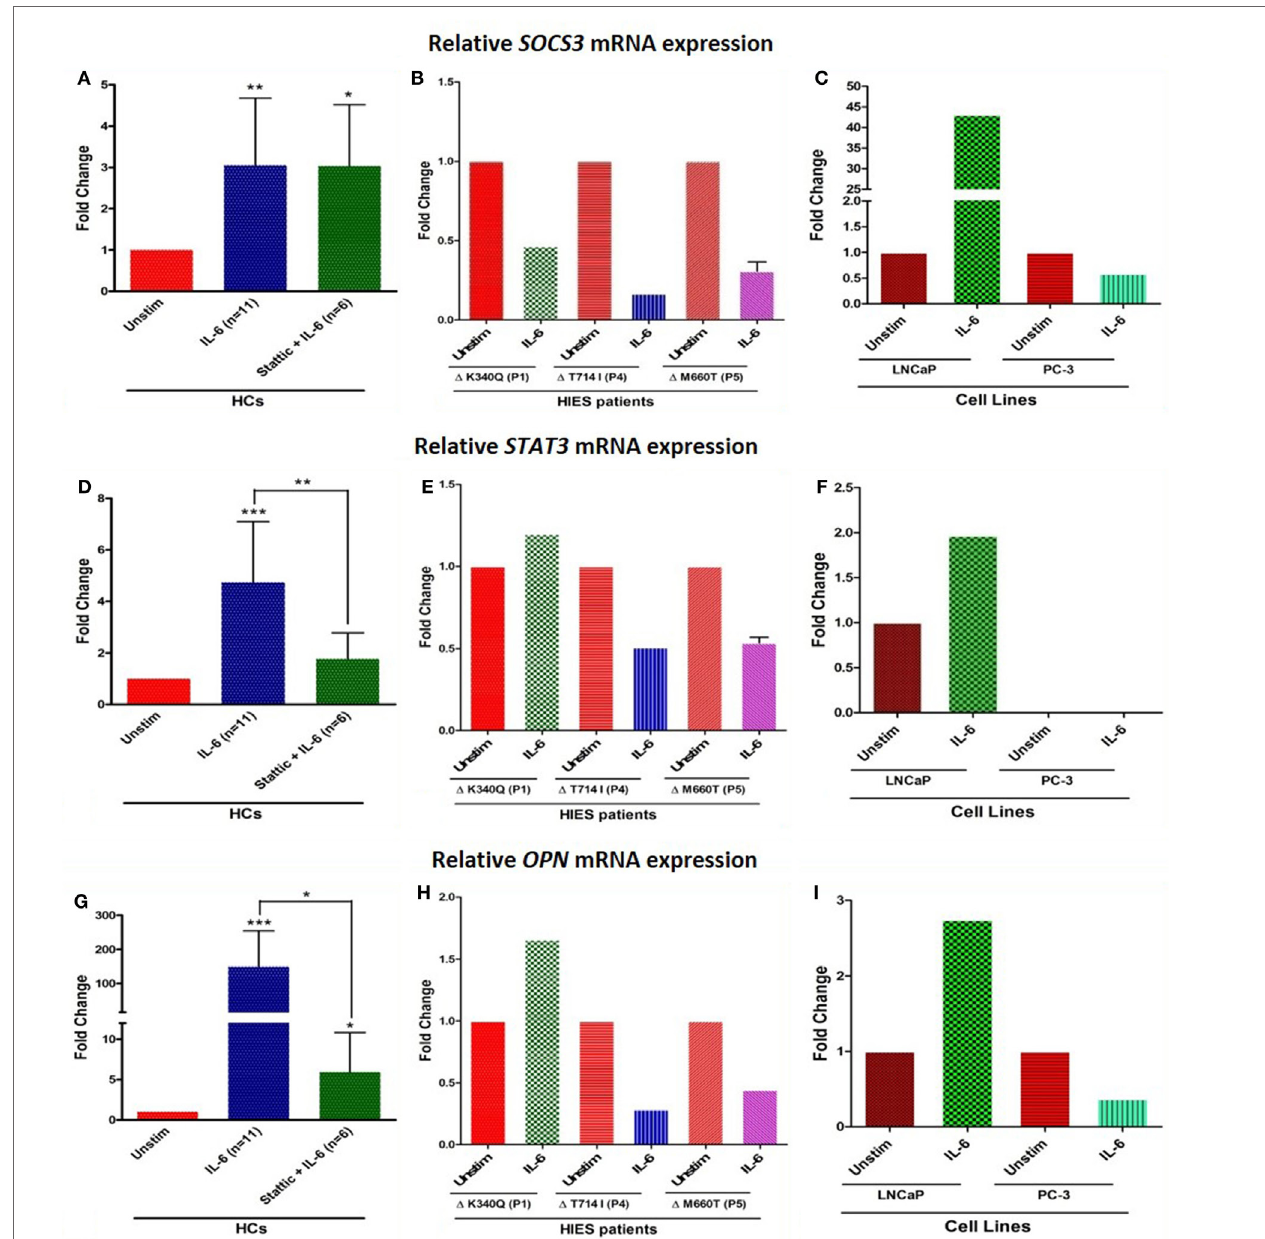
FigUre 4 | Bar graphs showing relative mRNA expression of SOCS3, STAT3 , and OPN in HC peripheral blood mononuclear cells (a,D,g) treated with either IL-6 alone or with stattic ; in hyper-IgE syndrome (HIES) subjects (B,e,h) treated with IL-6 alone and in LNCaP and PC-3 cells (c,F,i) treated with IL-6 alone. The primary transcript for each gene were assayed at least in duplicate and normalized to β -actin expression. Data represented as mean ± SD, * p < 0.05, ** p < 0.01, *** p < 0.001, paired t -test and Wilcoxon